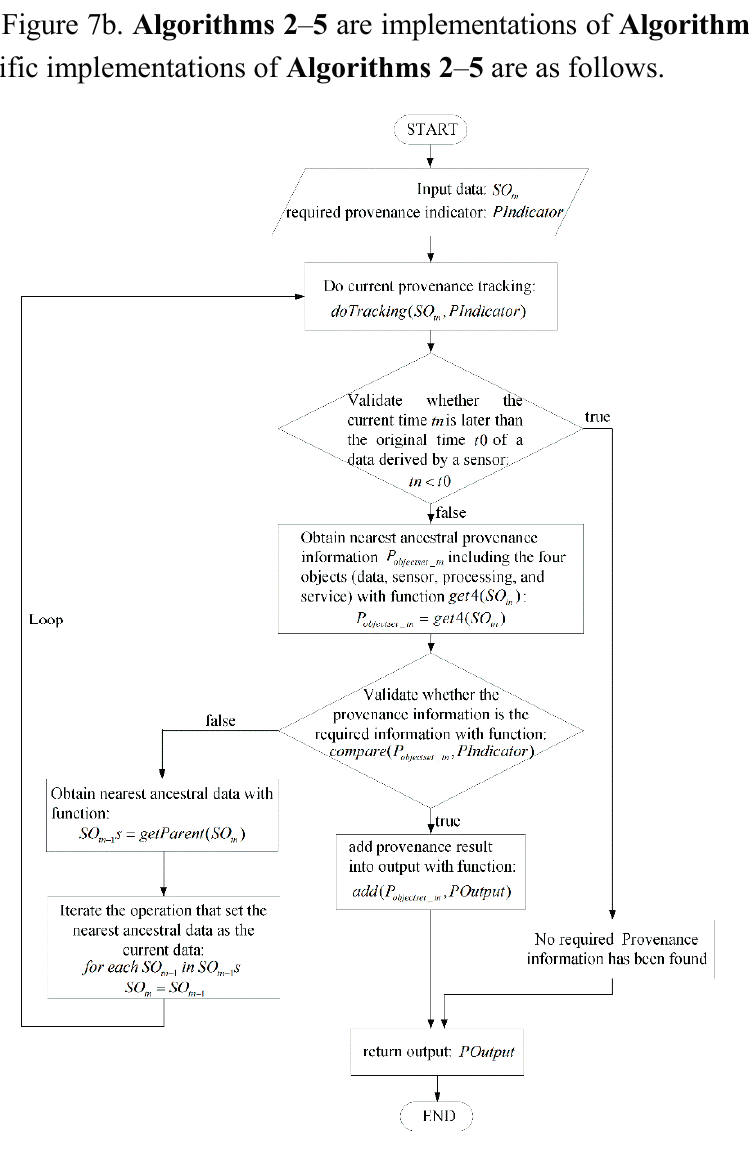
Figure 7. Flow of Algorithm 1